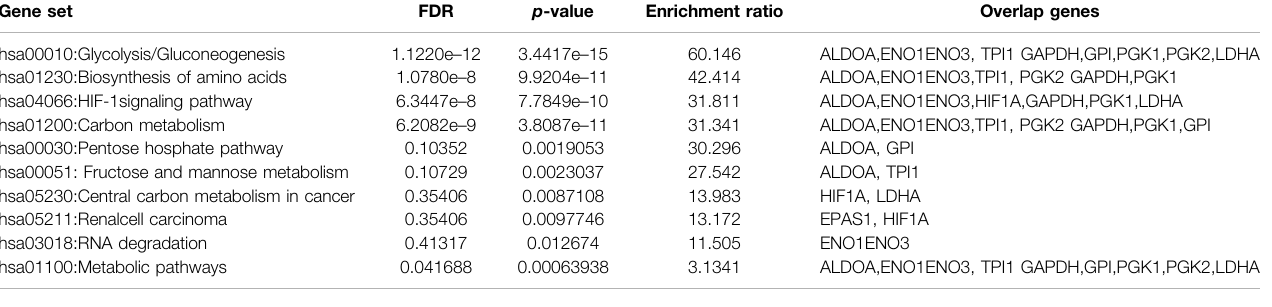
TABLE 5 | KEGG Pathway enrichment analysis of PGK1 gene – gene interaction network. Gene set FDR p -value Enrichment ratio Overlap